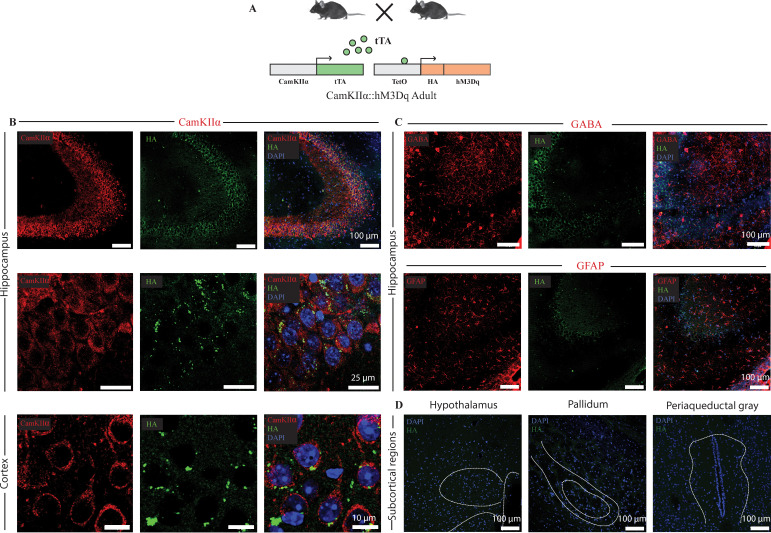
Selective expression of the HA-tagged hM3Dq DREADD in CamKIIα-positive forebrain excitatory neurons in adult CamKIIα-tTA::TetO-hM3Dq bigenic mice.(A) Shown is a schematic of the experimental strategy for the generation of the bigenic CamKIIα-tTA::TetO-hM3Dq mouse line to selectively drive the expression of the HA-tagged hM3Dq DREADD in CamKIIα-positive forebrain excitatory neurons. tTA – tetracycline transactivator. (B) Shown are representative confocal images indicating expression of the HA-tagged hM3Dq DREADD in the Hippocampus (upper and middle panels), and cortex (lower panel) as identified by HA/CamKIIα double immunofluorescence. The HA-tagged hM3Dq DREADD appears to be localized to the membrane of CamKIIα-positive forebrain excitatory neurons as observed in higher magnification photomicrographs. (C) HA-tagged hM3Dq DREADD expression was not observed in either GABA-positive neurons (upper panel), or GFAP-positive astrocytes (lower panel). (D) Immunofluorescence experiments revealed the lack of expression of HA-tagged hM3Dq DREADD in subcortical brain regions. Shown here is the lack of expression for the HA-tagged hM3Dq DREADD in the hypothalamus, pallidum and periaqueductal gray in sections stained for HA expression. All immunofluorescence experiments to address co-localization of the HA-tagged hM3Dq DREADD with neuronal excitatory and inhibitory markers, and astrocyte markers were performed on n = 4 per group.